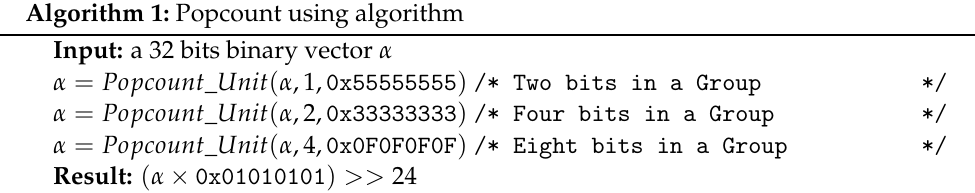
Algorithm 1: Popcount using